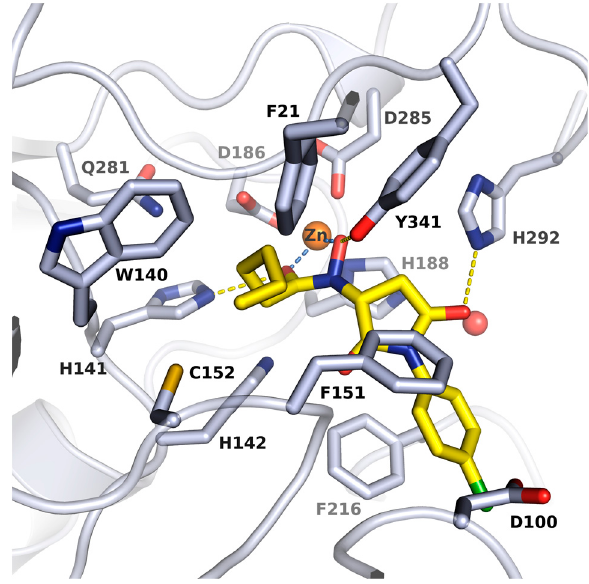
Figure 2. Crystal structure of smHDAC8/J1036 complex. Close-up view of the binding mode of J1036 in the smHDAC8 active-site cleft. Protein residues are shown as grey sticks, and J1036 is shown as yellow sticks. The catalytic zinc is shown as orange sphere while conserved water molecule is shown as a red sphere. Coordinations to zinc ion and hydrogen bond interactions to the protein are shown as dashed light blue and yellow lines respectively.